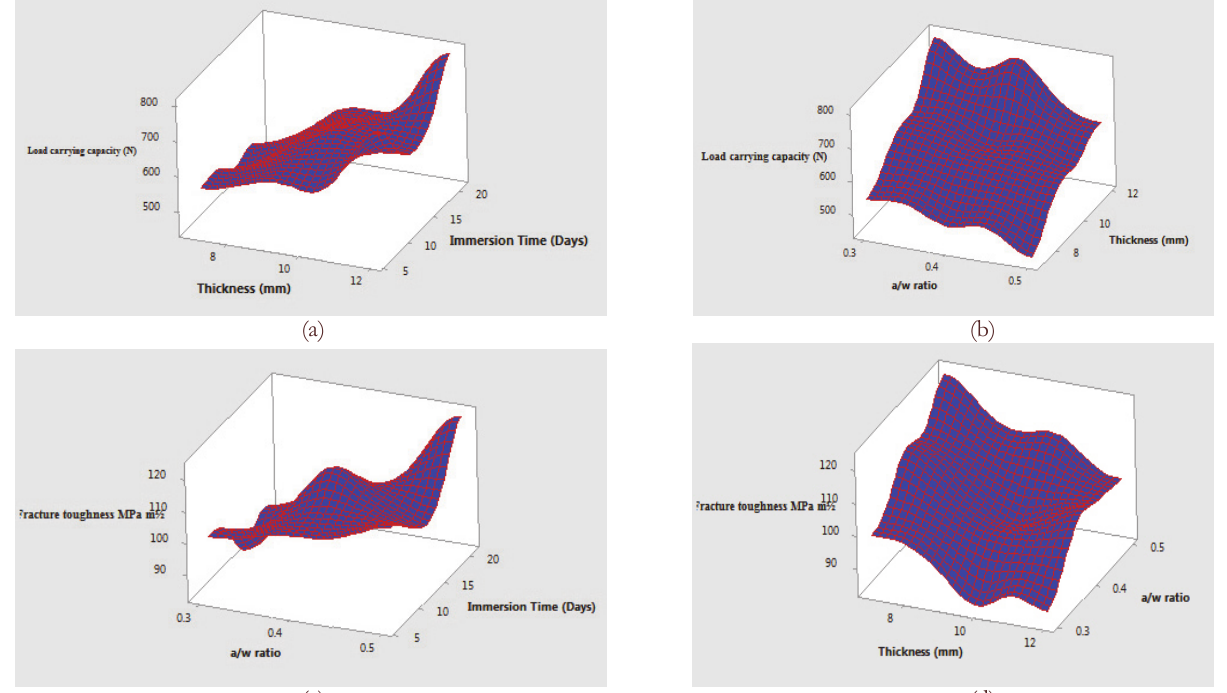
Figure 6: RSM graphs of different control factors V/S Load and Fracture toughness of SENB